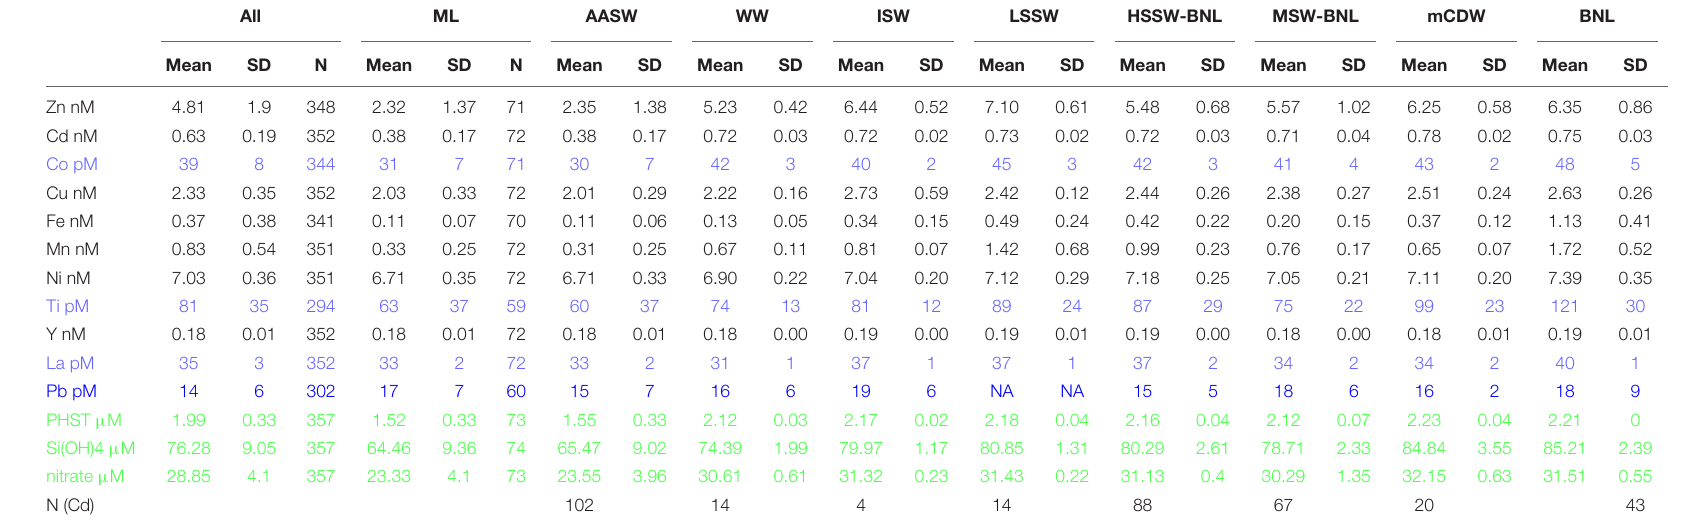
TABLE 2 | Average dissolved metal concentrations and nutrient concentrations, for all, in the mixed layer (ML), per water mass and bottom nepheloid layer ( Figure 3 ). All ML